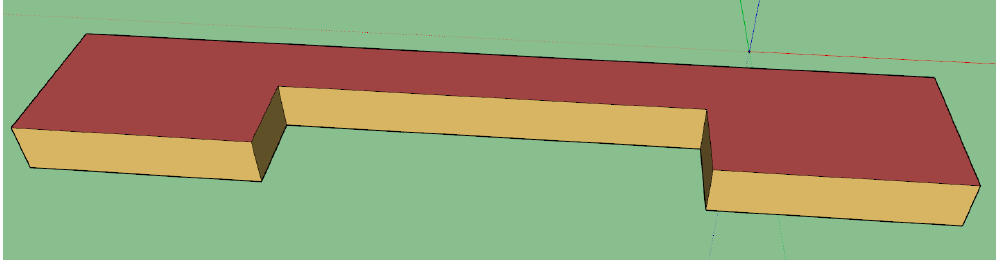
Figure 8. The 3D model from Scenario 1.